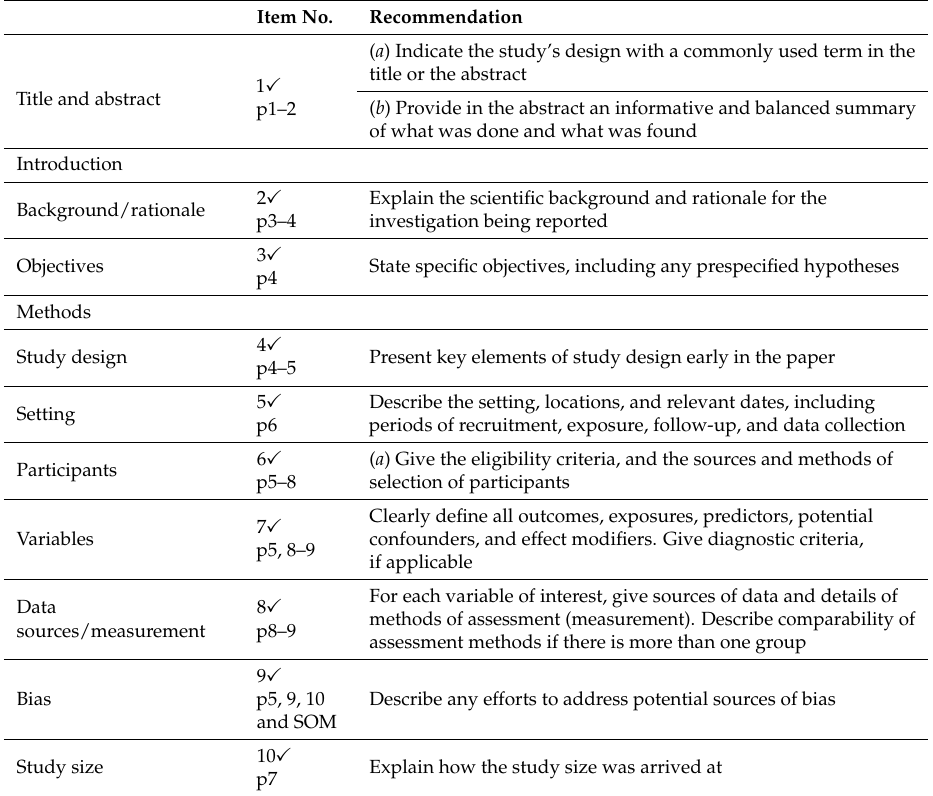
Table A2. Final model results after implementation of propensity score matching to the sample of children inhabiting repeatedly flooded and non-flooded villages. Table B1. STROBE Statement—Checklist of items that should be included in reports of cross-sectional studies.